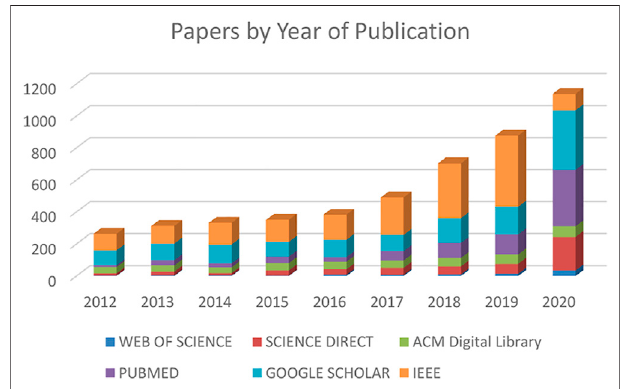
FIGURE 1 | Number of papers by year of